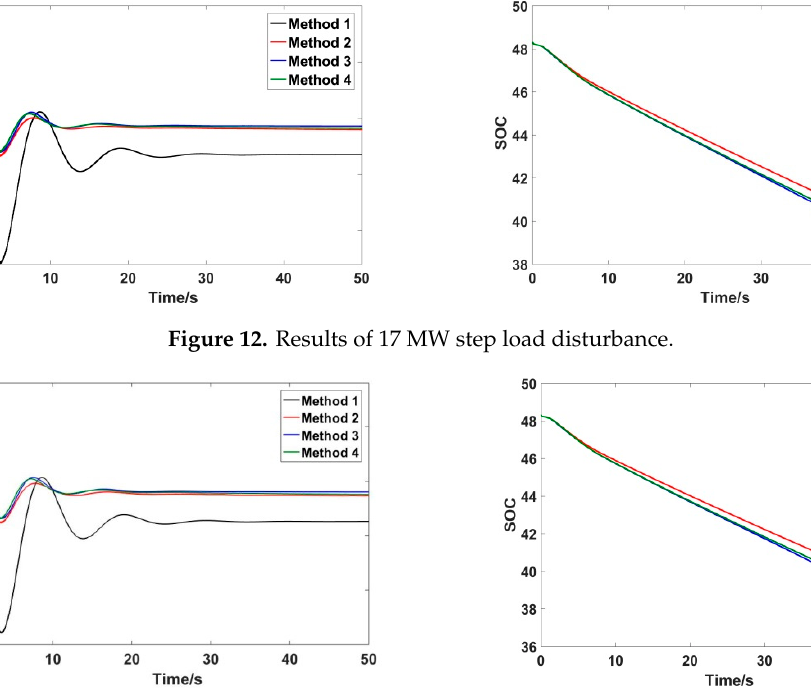
Figure 11. Results of 16 MW step load disturbance.